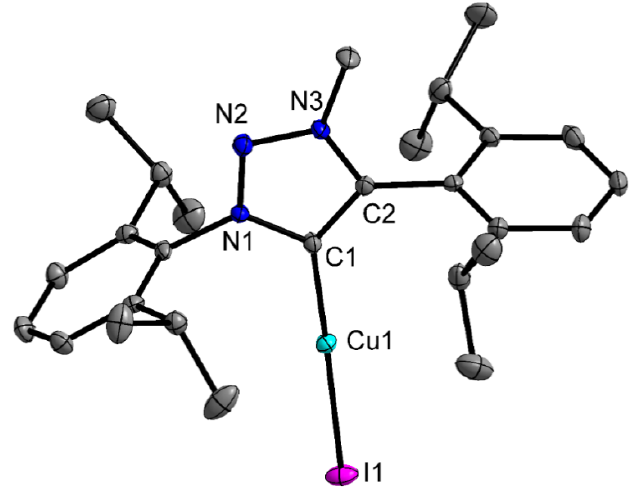
Figure 4. ORTEP-Plot of the complexes 1b . Hydrogen atoms are omitted for clarity. Ellipsoids are shown at 50%